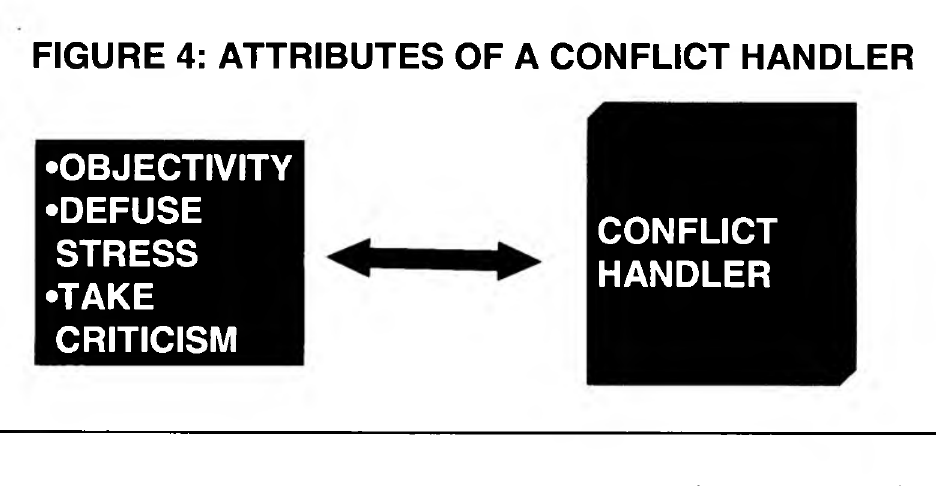
FIGURE 4: ATTRIBUTES OF A CONFLICT HANDLER